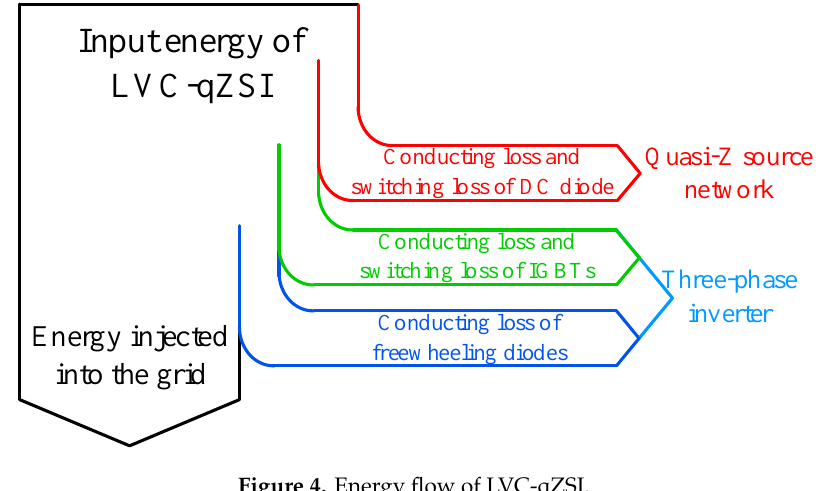
Figure 4. Energy flow of LVC-qZSI.